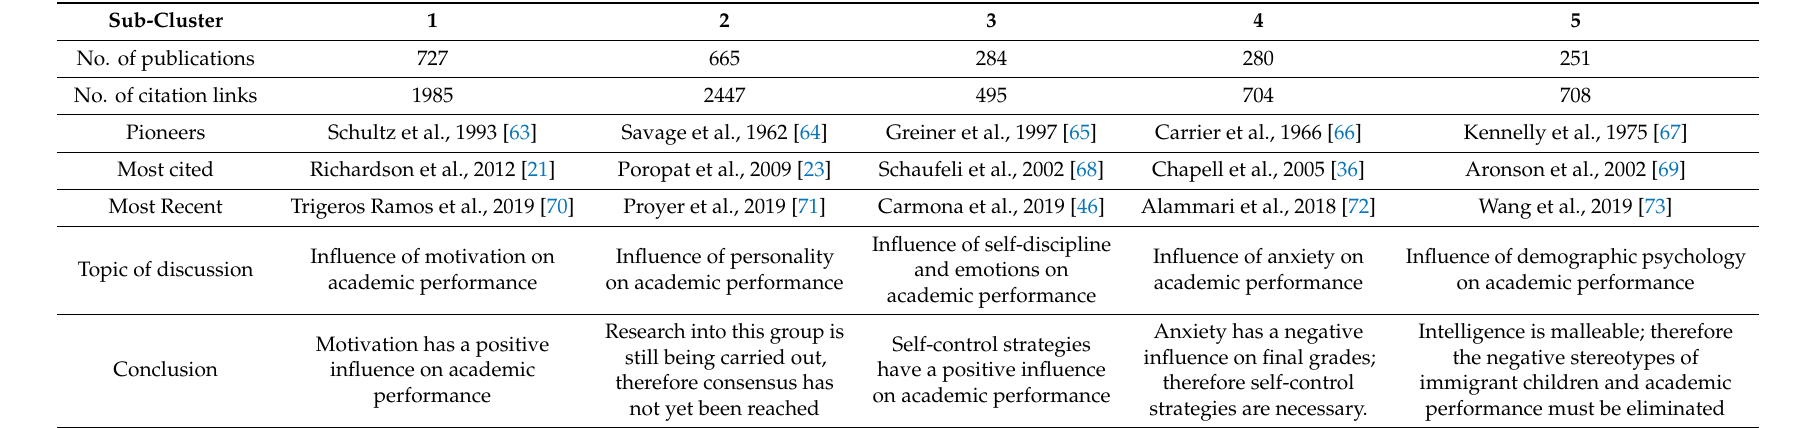
Table 4. The most important subclusters from group